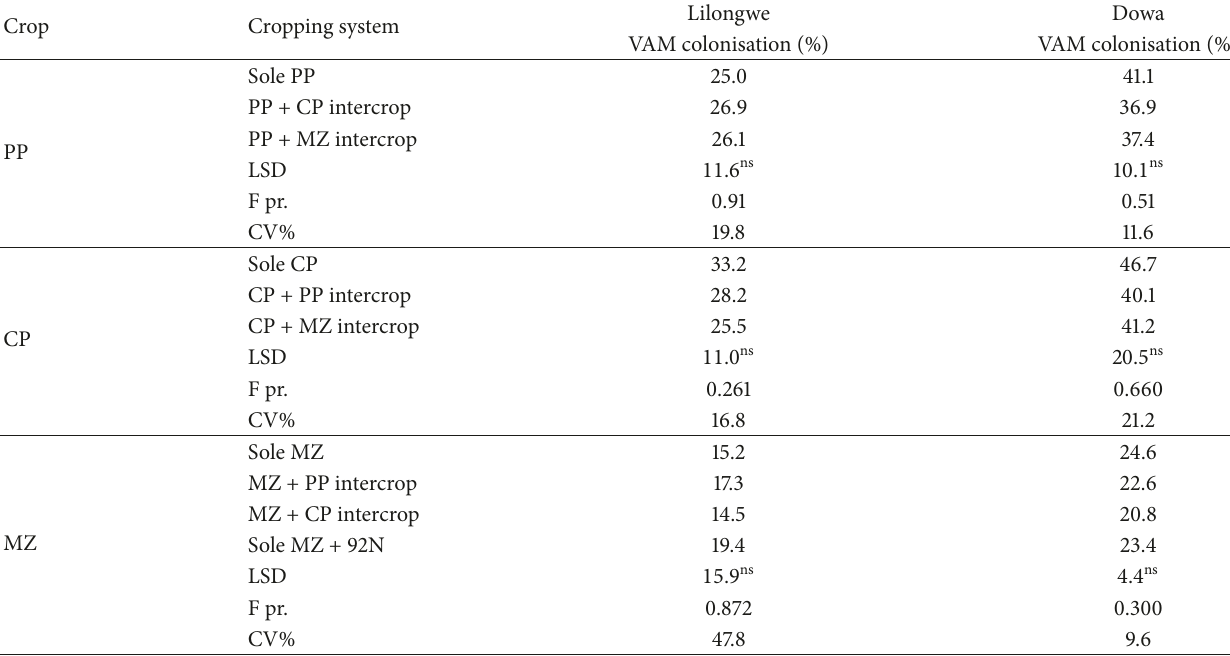
Table 1: Effect of cropping system on VAM fungal colonisation on pigeon pea, cowpea, and maize at the two study sites in year one (2013/14 cropping season).